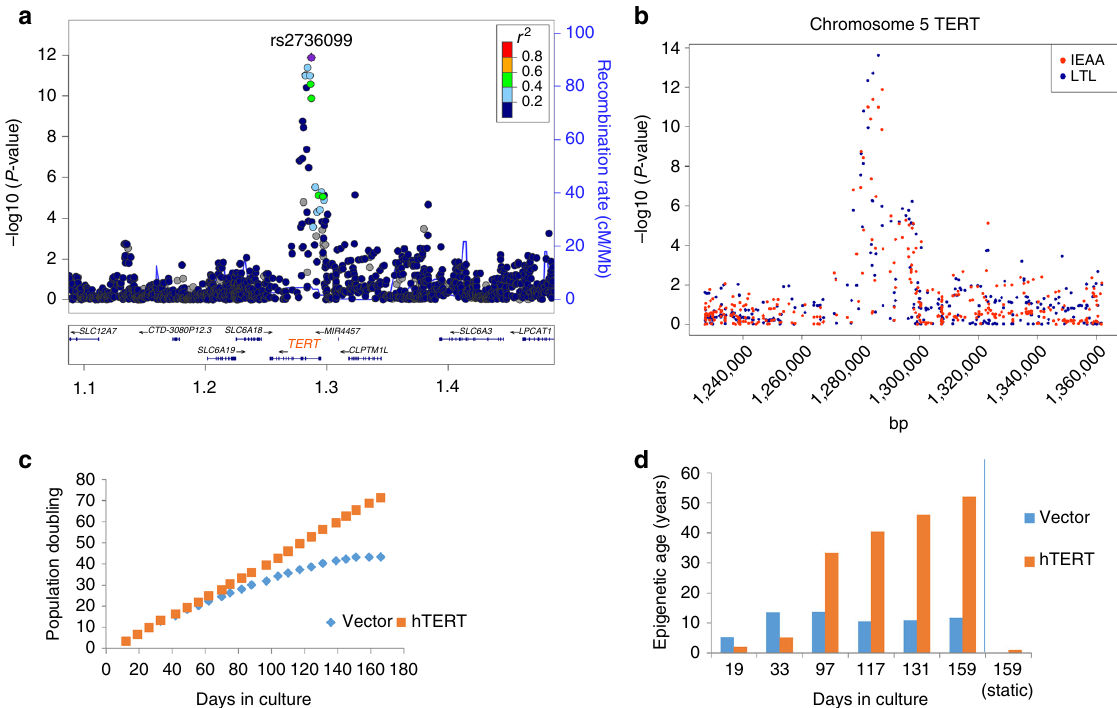
Fig. 3 Genetic analysis of the 5p15.33 TERT locus and in vitro studies of hTERT in fi broblasts. a Regional association plot of locus associated with IEAA. The y -axis depicts log-transformed meta-analysis P- values across all studies 1 – 15. The colors visualize linkage disequilibrium (LD) r 2 between rs2736099 (colored in purple) and neighboring SNPs. b TERT -locus association with IEAA (marked in red) overlaid with the association with leukocyte telomere length (LTL) given by Bojesen et al. 25 (marked in blue). Note that several SNPs in the TERT locus are associated with both IEAA and leukocyte telomere length at a genome-wide signi fi cant level. c Growth of human primary fi broblasts ( n = 46) represented as population doublings ( y -axis) vs. days in culture ( x -axis). d Adjusted epigenetic age of n = 14 individual samples ( y -axis) vs. days in culture ( x -axis). The adjusted age estimate was de fi ned as difference between Horvath DNAm age minus 28 years, since the former exhibited a substantial offset in fi broblasts. DNAm ages are increased in the hTERT expressing cells in the four later time points (days 97, 117, 131, and 159) resulting in a paired Student's t -test P -value of 0.043. However, no increase in DNAm age can be observed in cells that are static (last